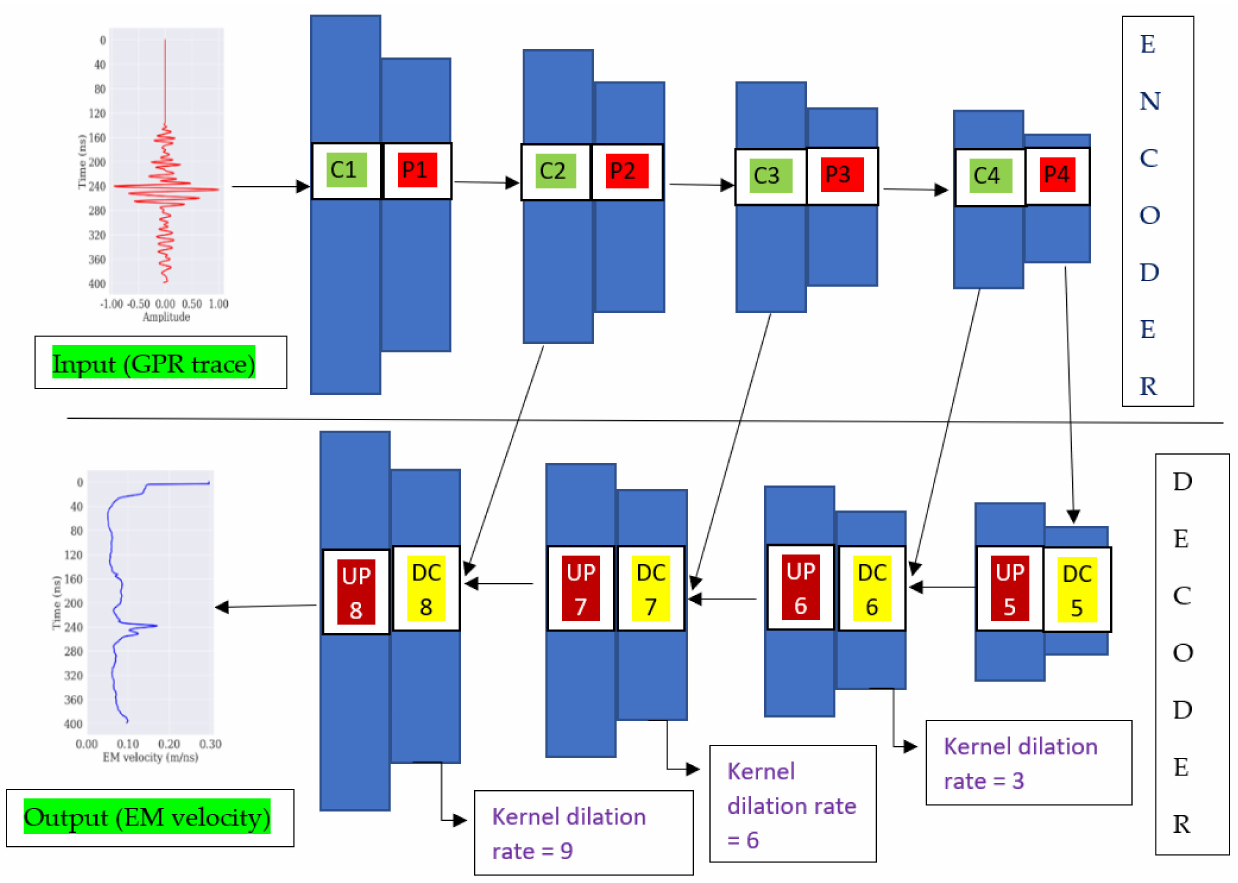
Figure 3. Schematic diagram of DeepLabv3+ based our Deep Convolutional Neural Networks (DCNNs). In Figure 3, the input to DCNNs is a GPR trace, and the output is an EM velocity model. C and P indicate 1D convolution and 1D max pooling layers, respectively. DC and UP indicate 1D deconvolution and 1D up-sampling layers, respectively. There are 16